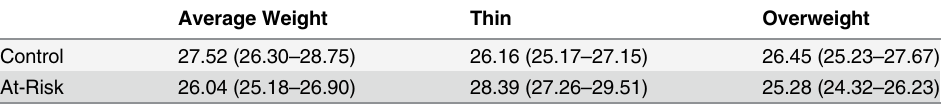
Table 3. Means and 95% confidence intervals for the total percent of time within populated environ- ments participants spent looking at avatar dyads of each body size.